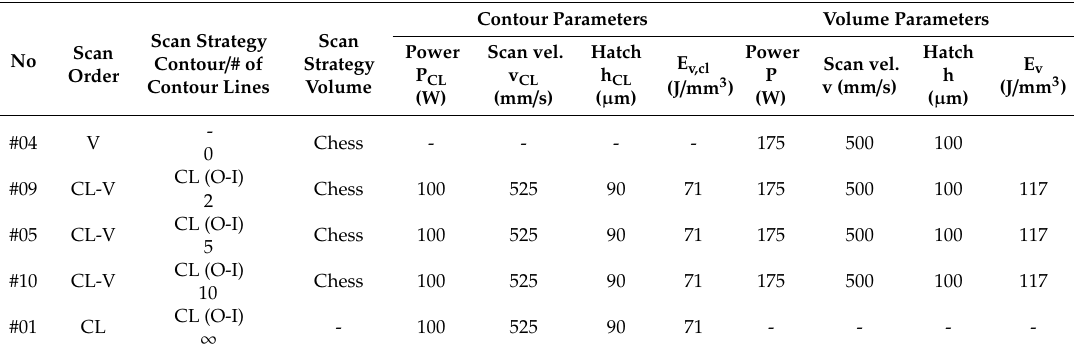
Table 3. Samples used to compare di ff erent contour line